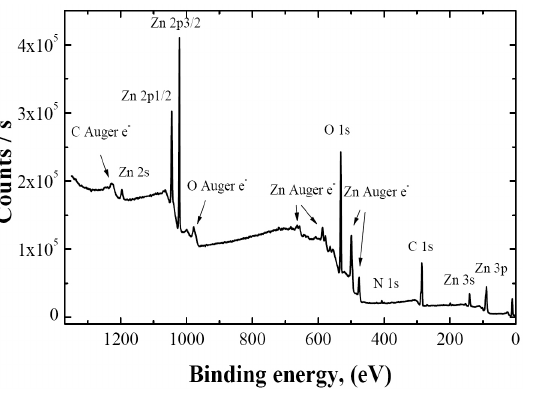
Figure 8: Deconvoluted XPS N 1s peak.